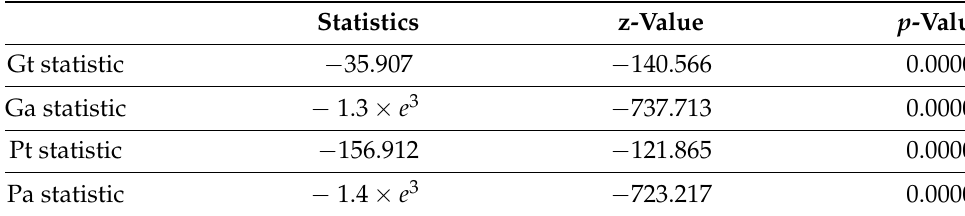
Table 4. Results of covariate cointegration